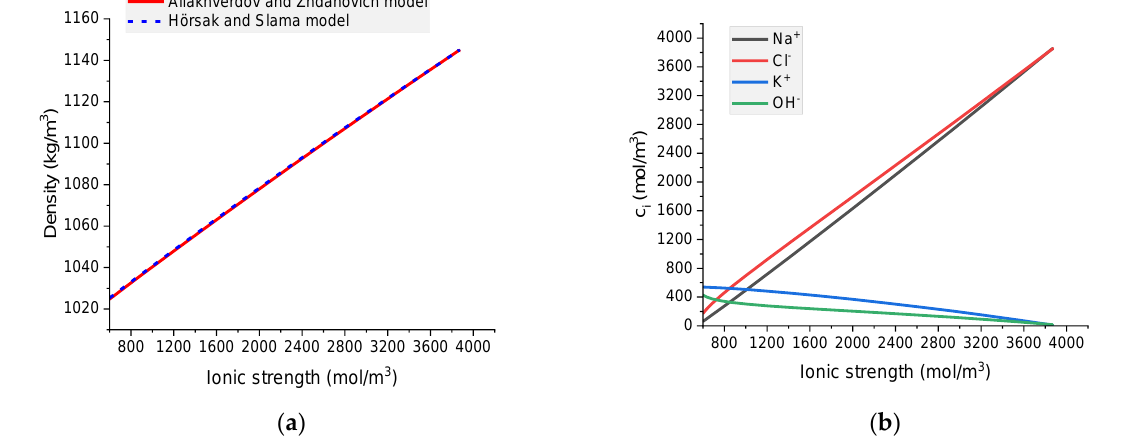
In Figure A1 comparison of densities calculated based on Allakhverdov and Zhdanovich [58]; and Hörsak and Slama [72] models for various ionic strengths and the solution compositions are presented. Both models give very similar results in a wide range of concentrations (ionic strength).